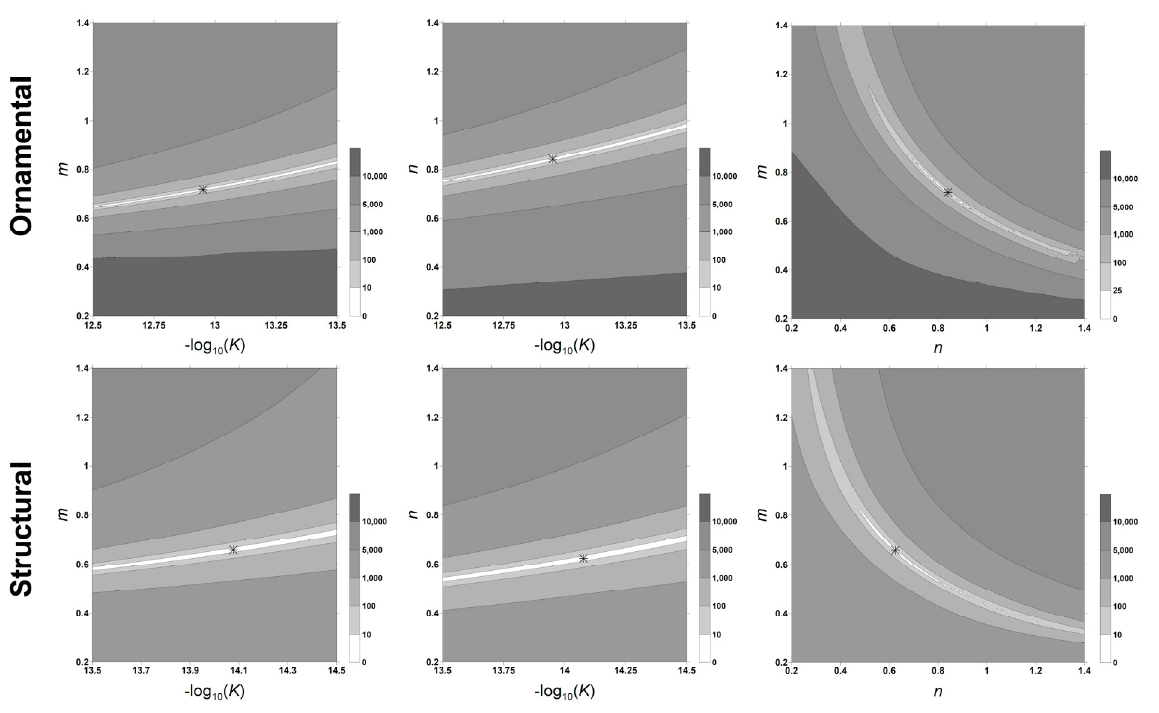
Figure 2. Error surfaces for both lithotypes and two-by-two combinations of the parameters (keeping the other one constant).